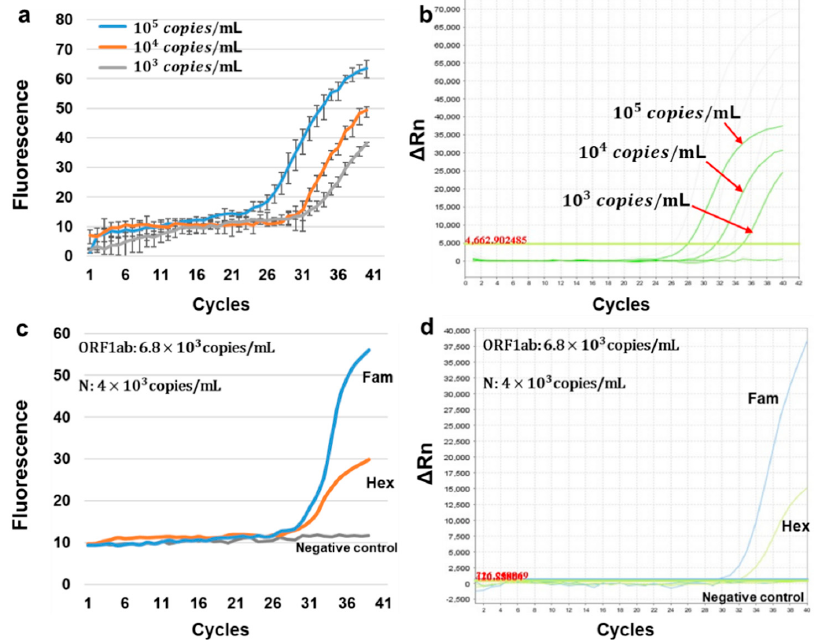
Figure 4. ( a ) HDLRT-qPCR gradient amplification curves for positive quality control substance from Daan Gene Co., Ltd.’s COVID-19 rapid test kit. ( b ) Positive quality control substance from Daan Gene Co., Ltd.’s COVID-19 rapid test kit amplification curves for real-time PCR amplification (ABI-STEPONE). ( c ) Weak positive quality control reference material of 2019-nCoV pseudovirus RNA in oral ucous matrix amplification curves for the HDLRT-qPCR system. ( d ) ABI-STEPONE real-time PCR amplification system weak positive quality control reference material of 2019-nCoV pseudovirus RNA in oral mucous matrix amplification